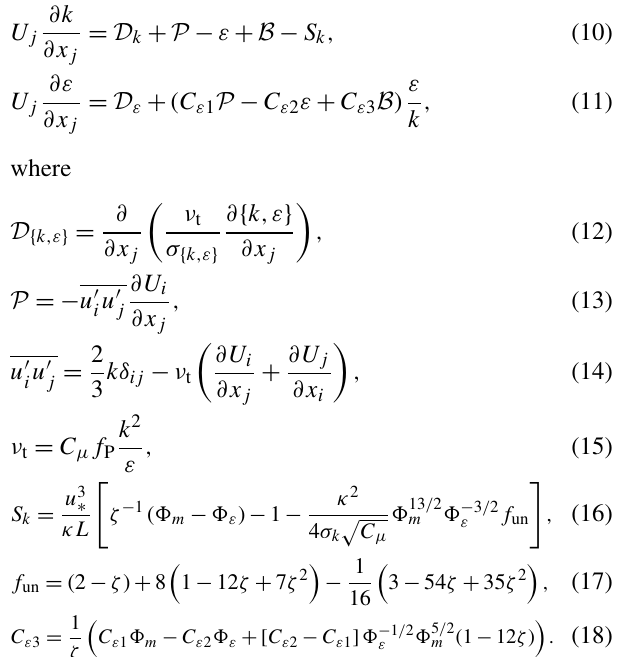
= 5km. Only every fourth cell is in